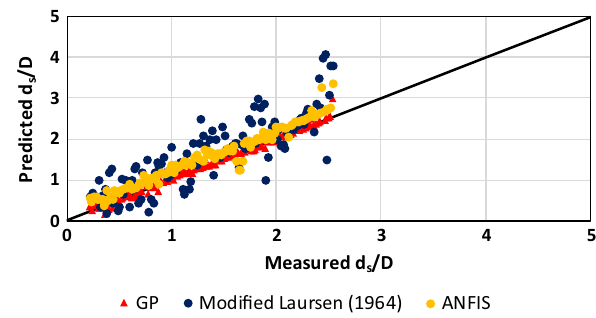
D versus measured val- s /